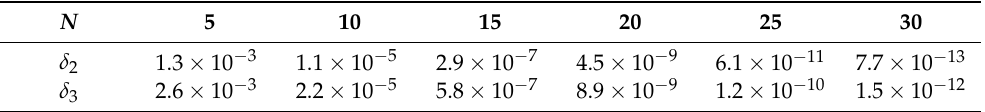
Table 4. Relative errors of expressions (21) for example 2.